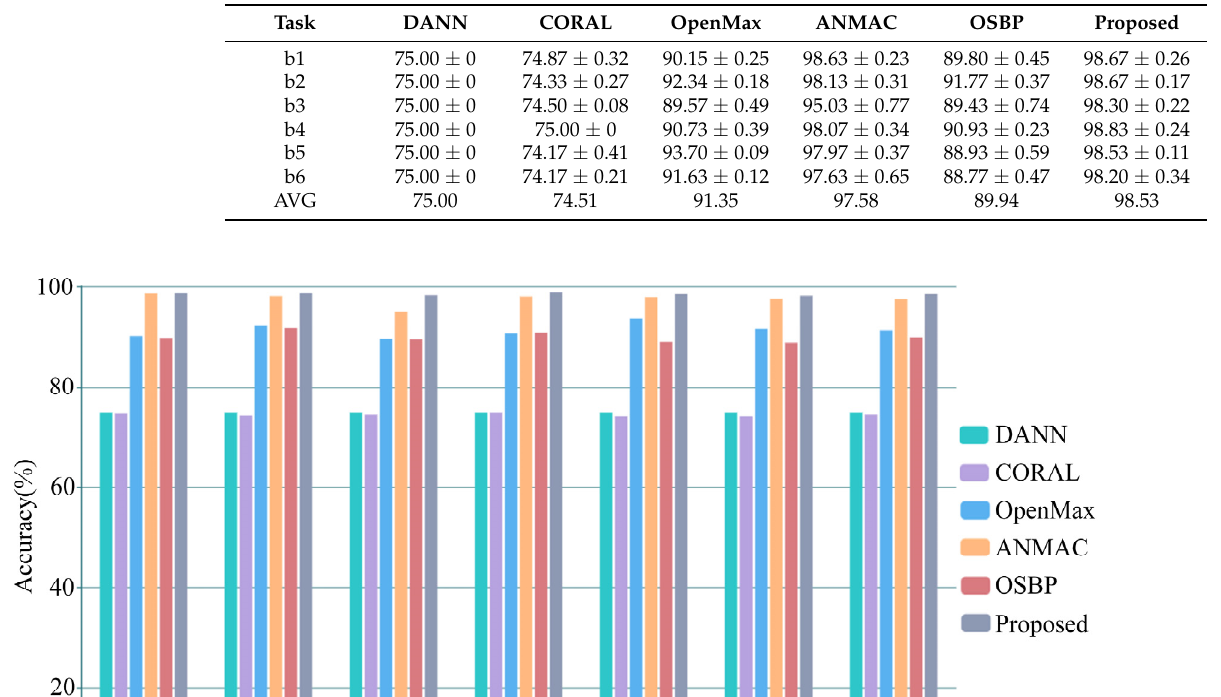
Table 5. Diagnosis results in the CWRU dataset (accuracy (%) ± standard deviation).